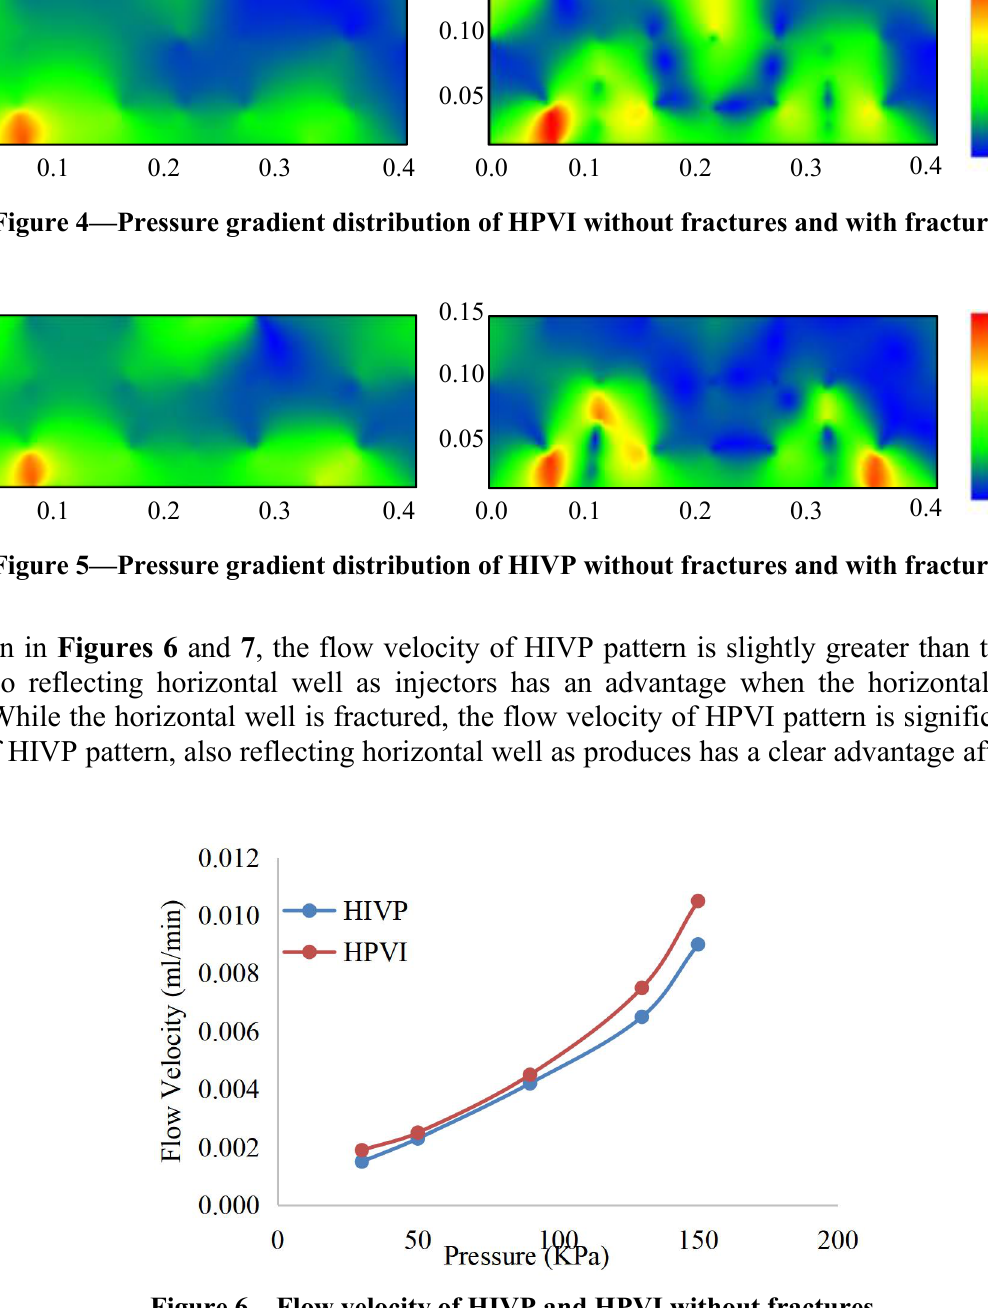
Figure 6—Flow velocity of HIVP and HPVI without